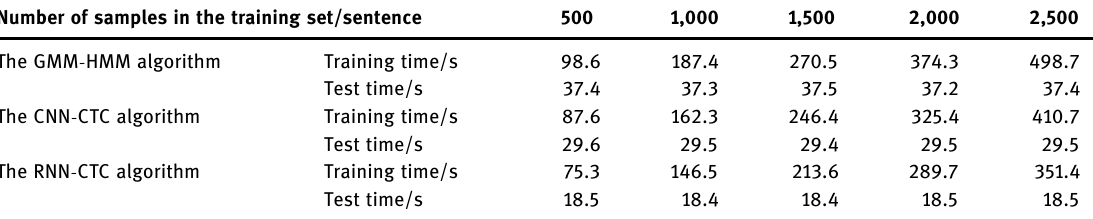
Table 1: Training and test time of three speech recognition algorithms under di ff erent numbers of samples in the training set Number of samples in the training set/sentence